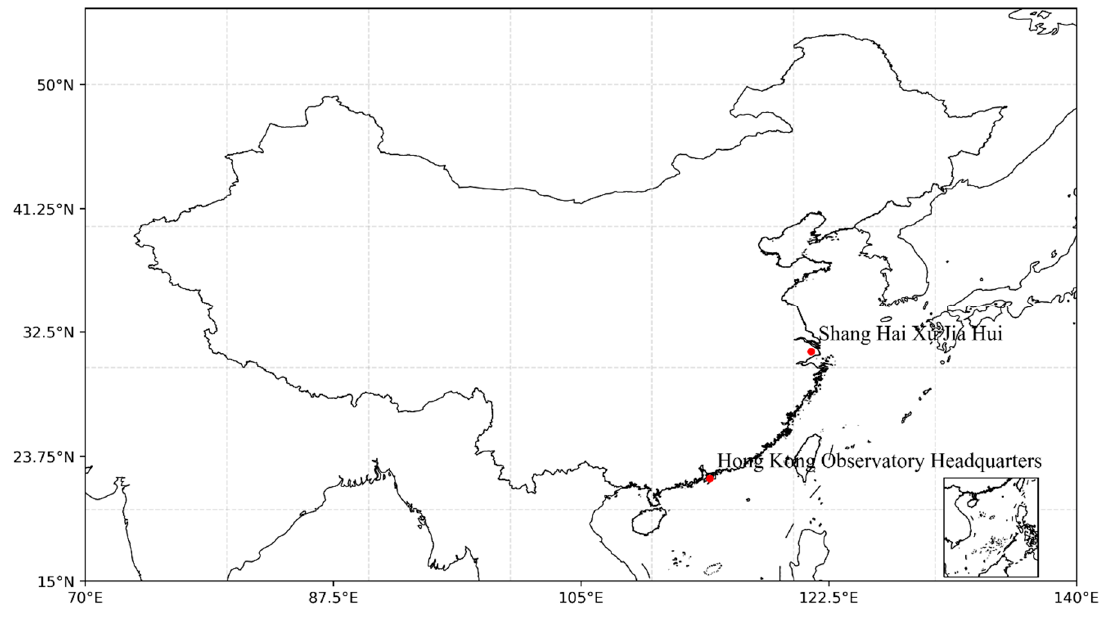
Figure 1. The locations of the two observatories.